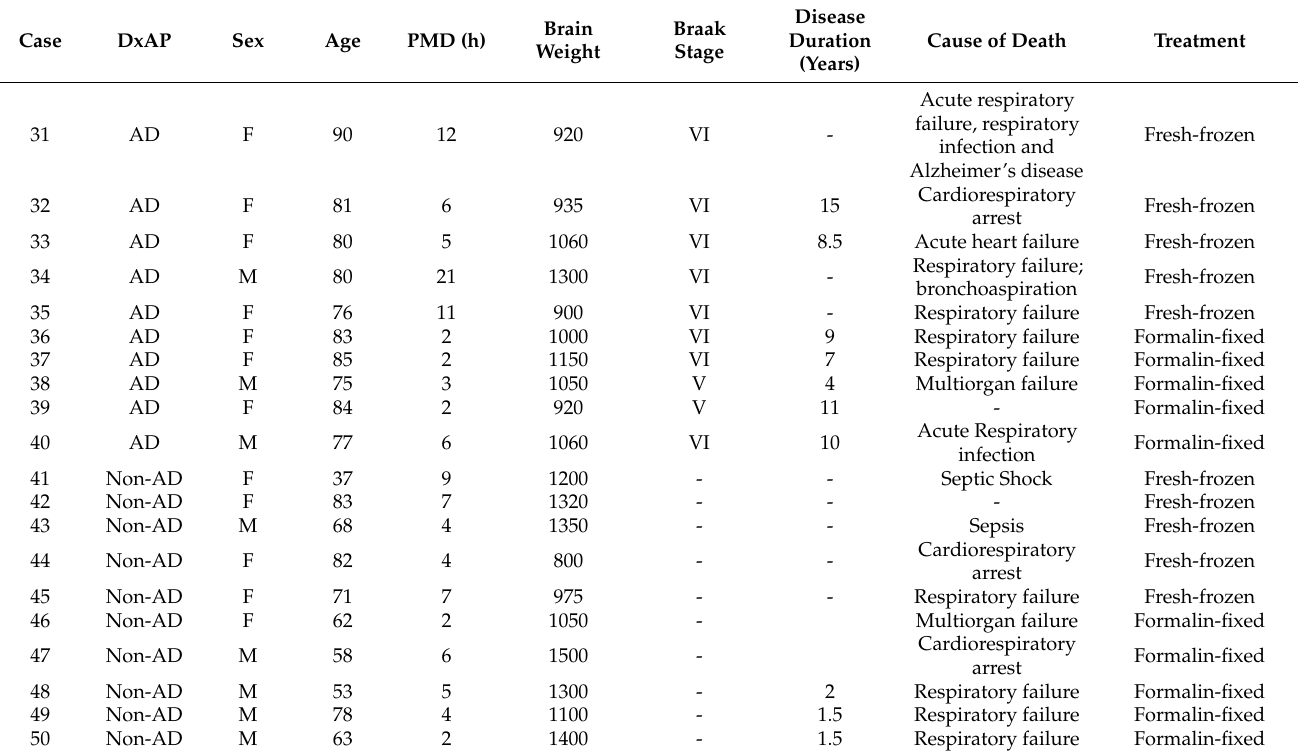
show significant differences between non-AD and AD cases (Figure 2E,F). Western blot quantification also did not reveal differences in SST expression (Figure 2G). Table 1. Human samples of olfactory bulb used in this study. DxAP (anatomopathological diagnostic); PMD (postmortem